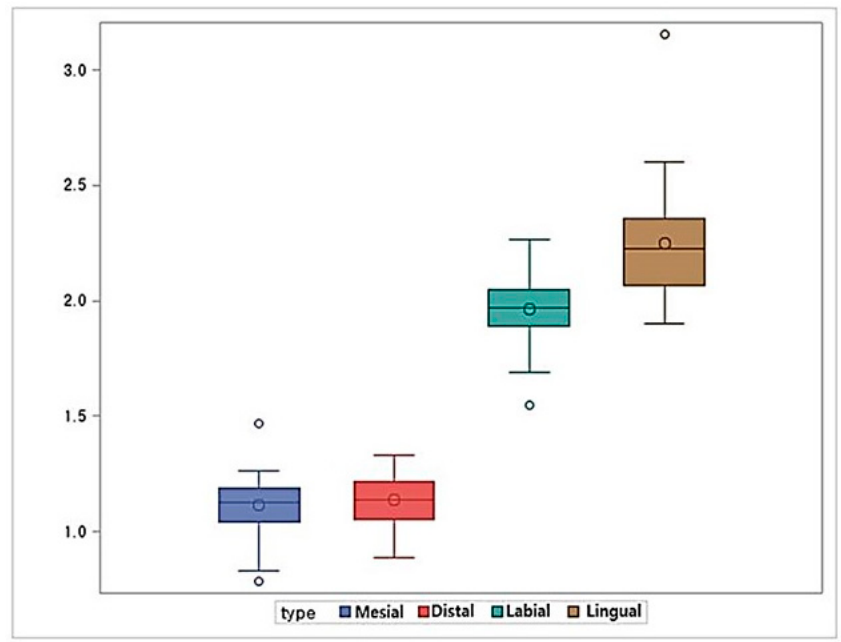
Figure 6. Average dentin thickness (mm) in mesial, distal, labial, and lingual directions.